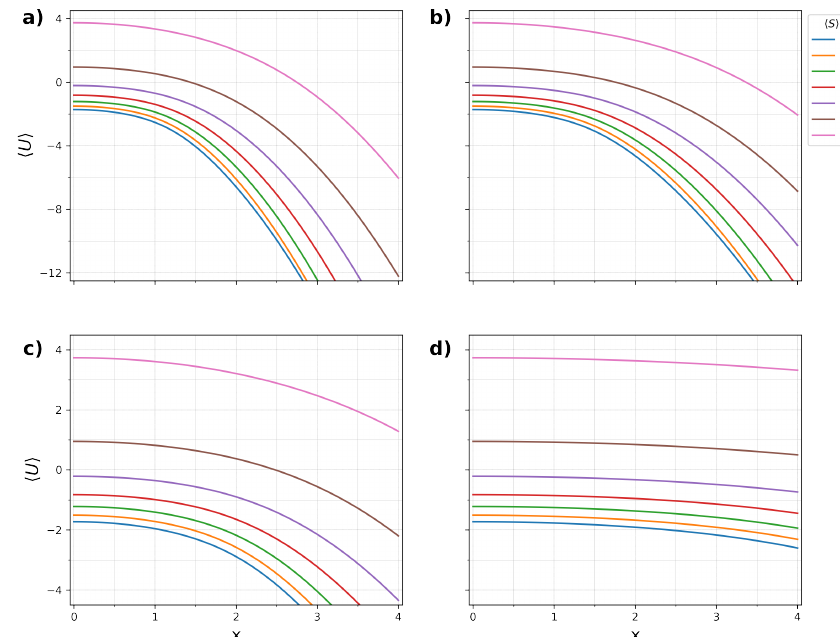
Figure 5. The behavior of the internal energy as a function of the dimensionless parameter x , at constant values of the entropy, is presented. The entropy S takes the values 2 to 8, in steps of one, in increasing order from the down curve to the up curve. As in the previous figures, ( a – d ) stand for values of the asymmetry parameter α = 1, 1.5, 0.5 and 0.1, respectively. The different thermodynamical quantities are depicted for negative values of the asymmetry parameter α in Figures